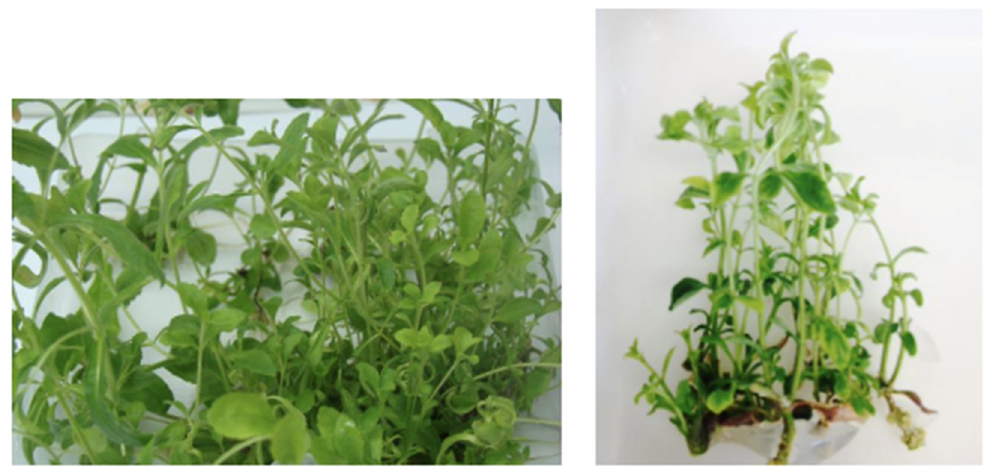
Figure 1. Stevia plantlet growing in PLANTFORM ( left ) and solid medium ( right ).